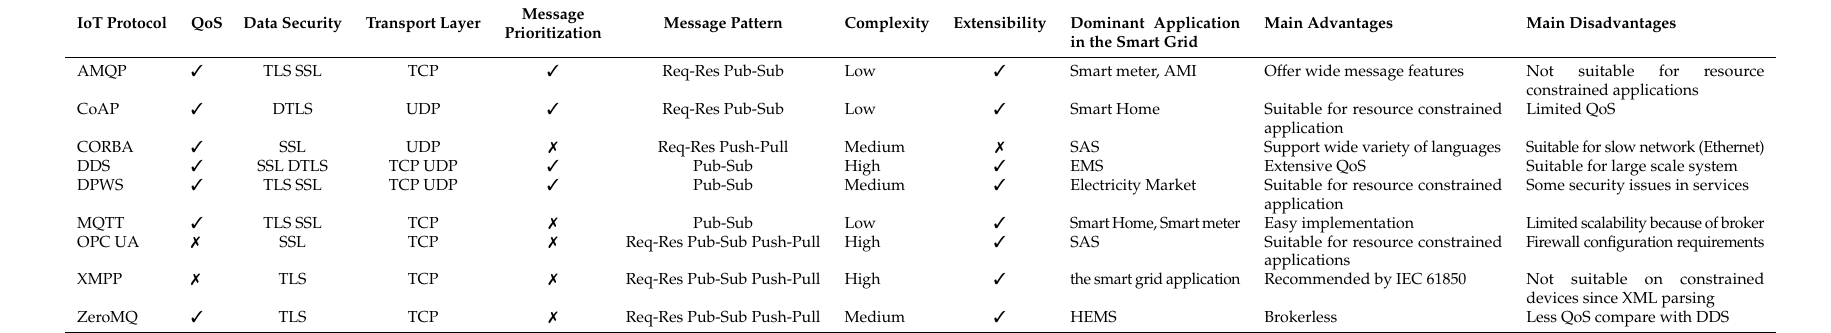
Table 4. Comparison of IoT protocols characteristics.